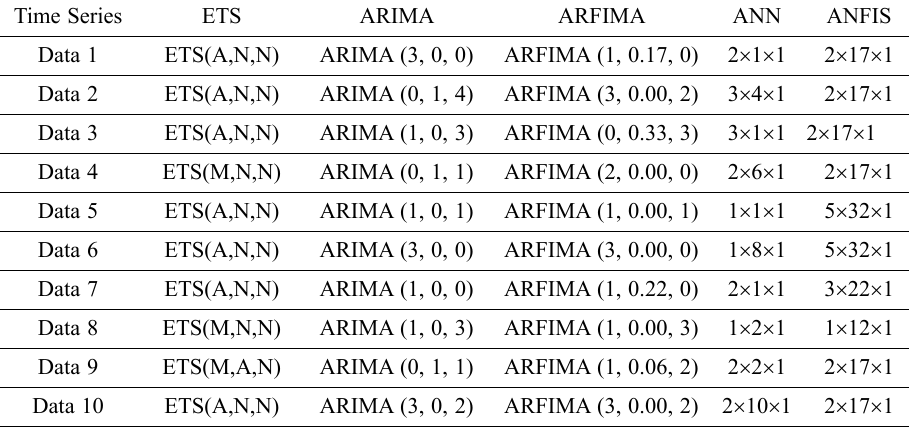
Table 3. Forecasting models selected for the ten time series under